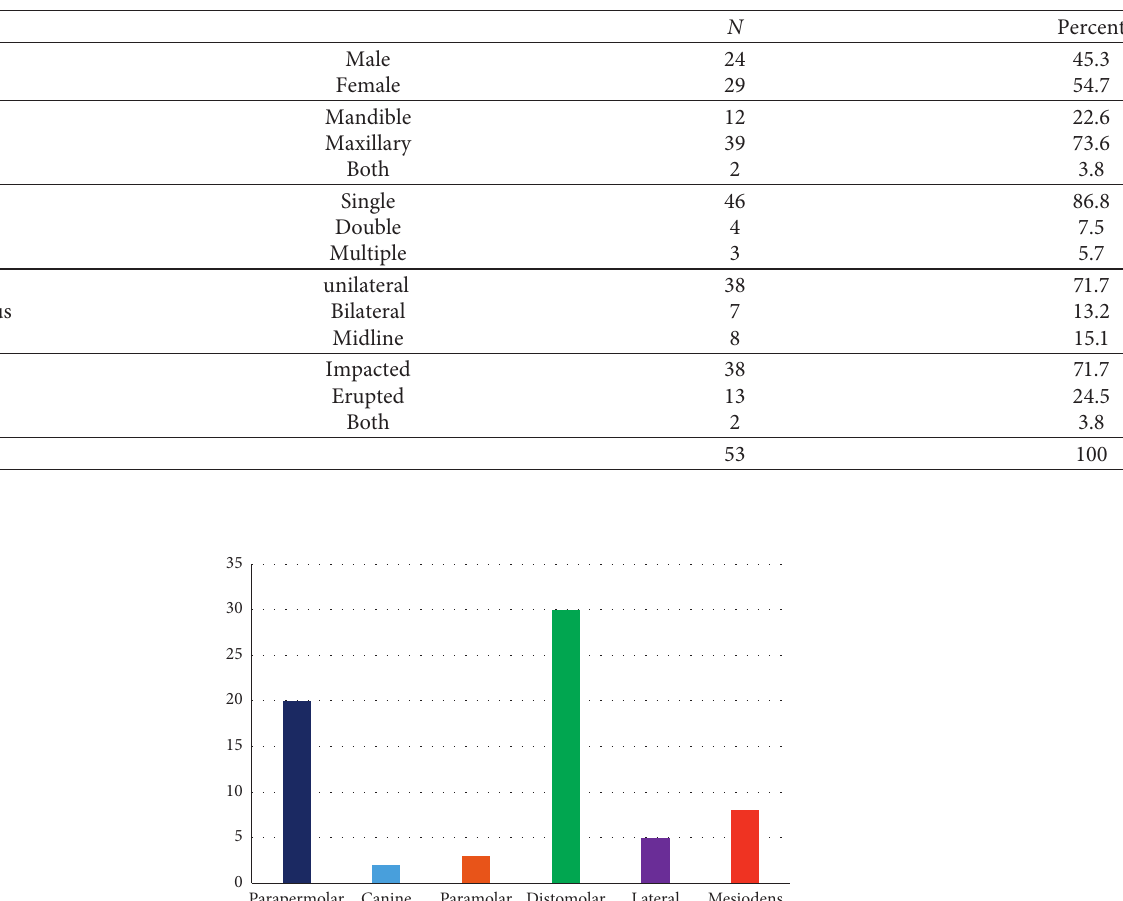
Table 1: Frequency of supernumerary teeth in the study population.